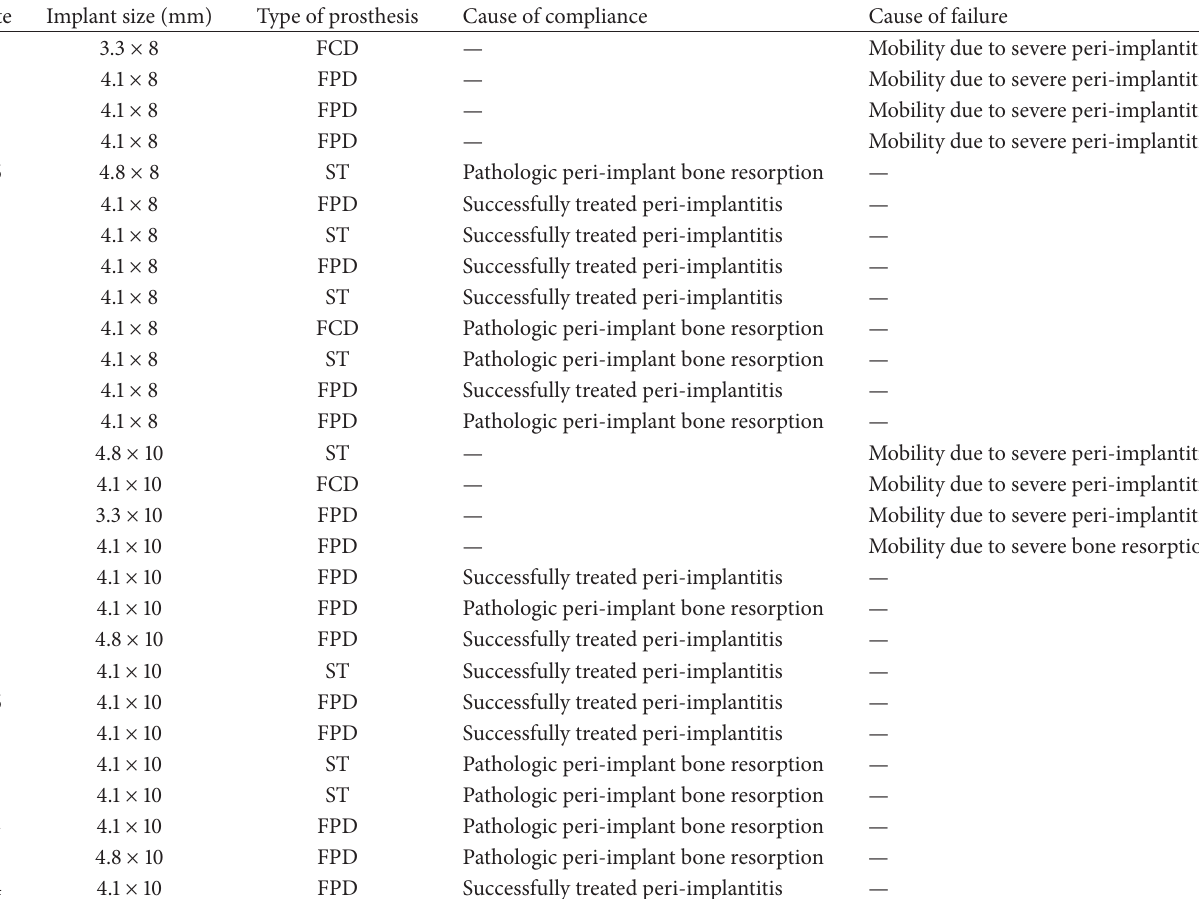
Table 4: Short and standard implants distribution: compliances and